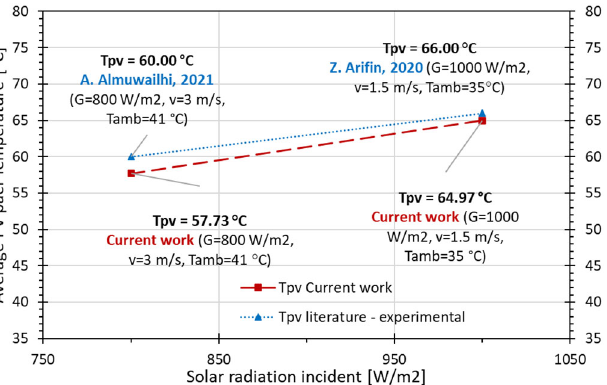
Figure 6. Validation of the numerical simulation—base case—PV panel without heat sink.